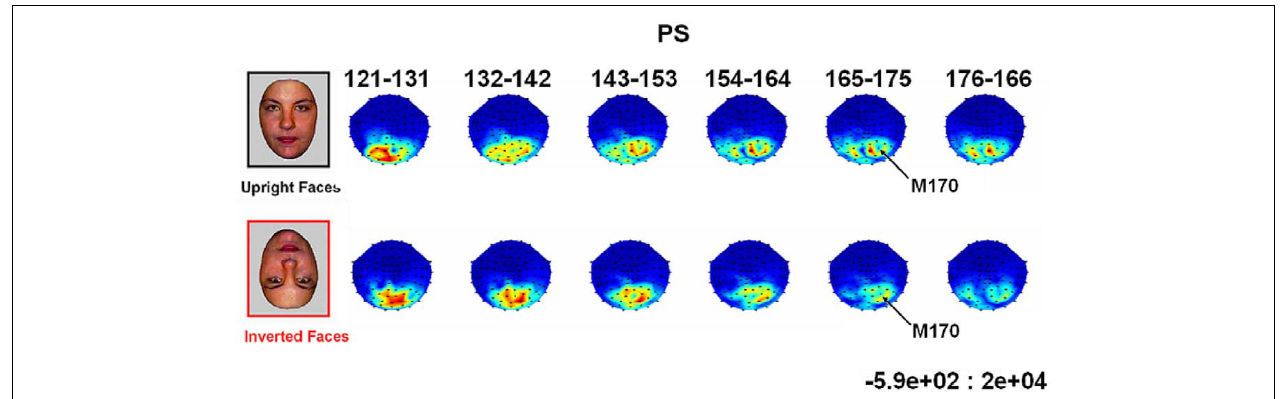
component in Experiment 2 (viewed from above, nasion upward; data are interpolated linearly between sensors, indicated by black dots, after